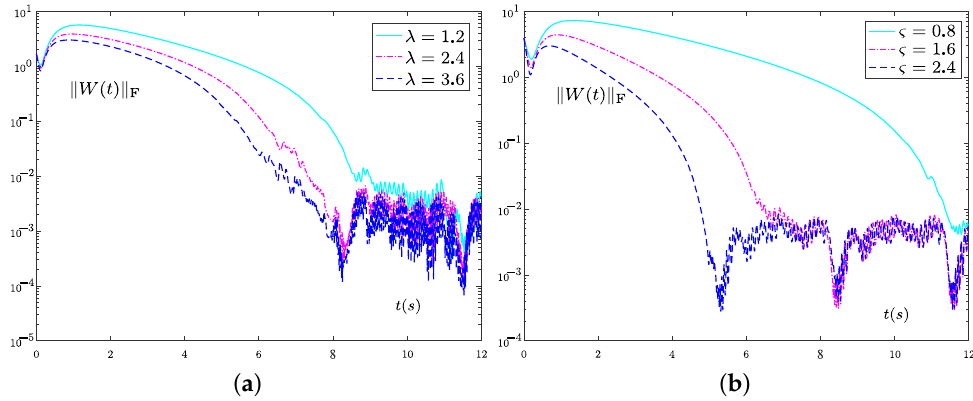
Figure 4. Error norms (cid:107) W ( t ) (cid:107) of ADIZNN (19) with different parameters for the DSE with (35) in F linear noise z i ( t ) = 16 t + 4. ( a ) Fixed λ = 1, different ξ . ( b ) Fixed ξ = 1, different λ